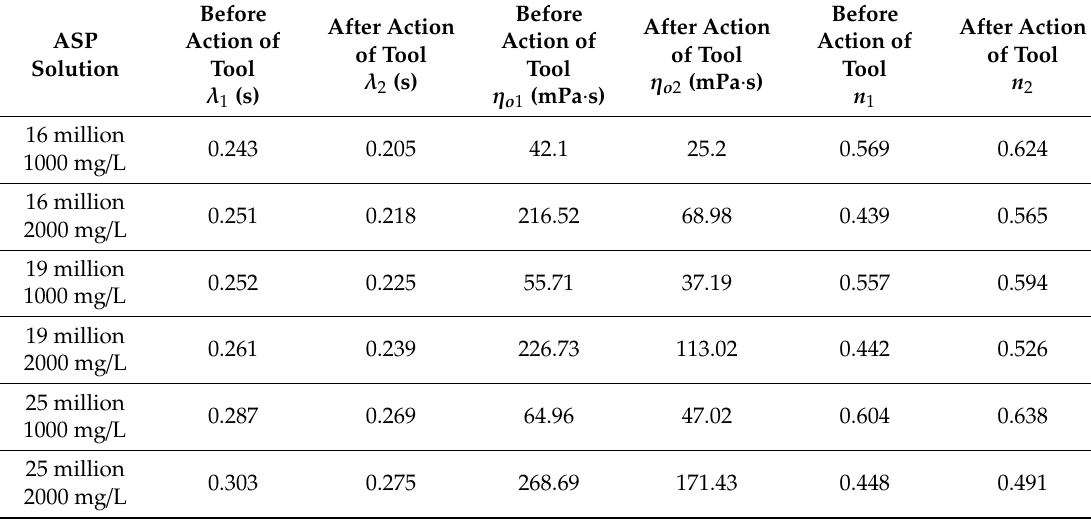
Table 3. Physical parameters before and after the action of the di ff erent medium